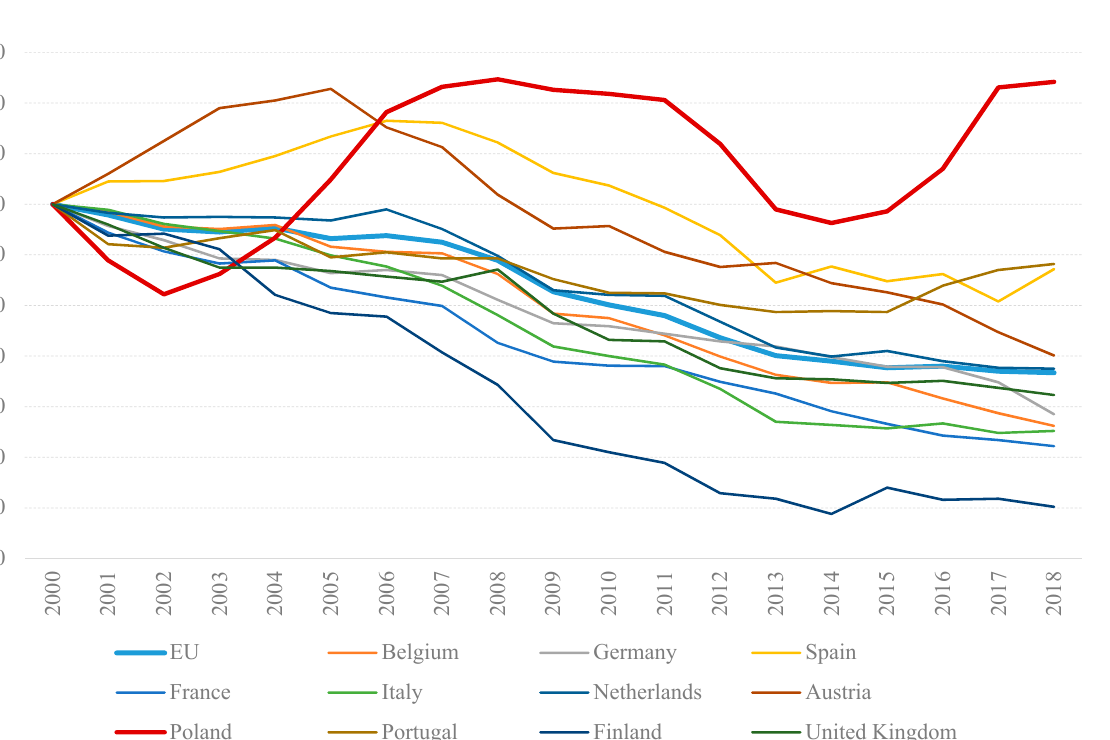
Source: European Environment Agency (EEA), European Commission—Directorate-General for Climate Action (DG CLIMA), Eurostat, access dated on 5 January 2021.